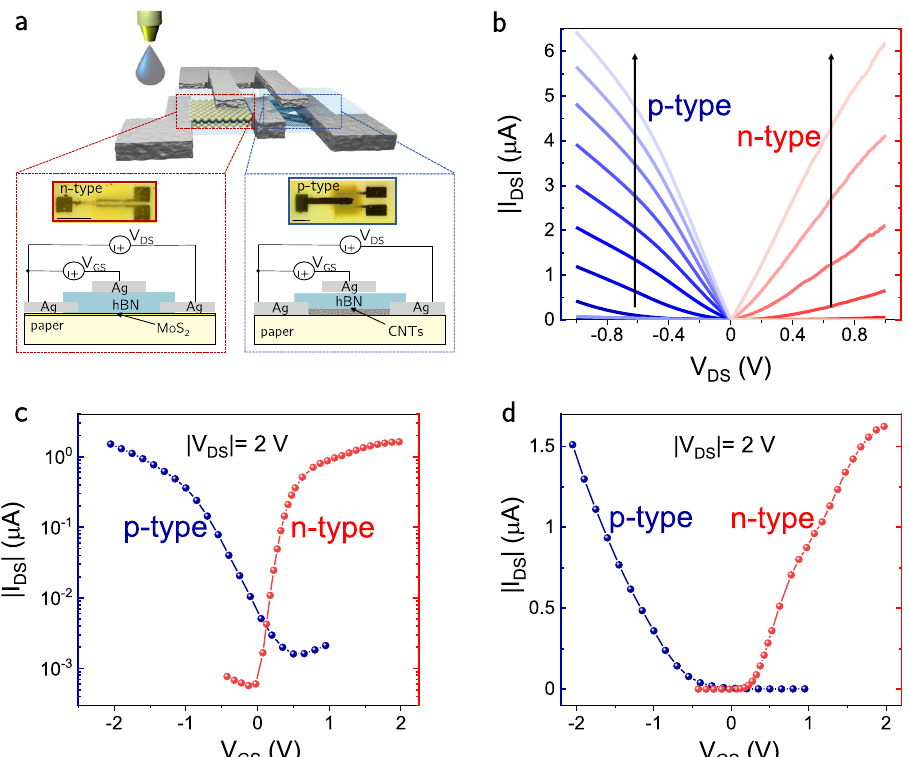
Fig. 1 Optical images and electrical characterization of the CNTs FET and MoS 2 FET in ambient conditions. a Sketch showing a CMOS inverter made of an inkjet-printed CNTs p -type FET and an inkjet-printed MoS 2 n -type FET. Inset, optical micrograph of both types of FET fabricated on paper, the scale bars correspond to 500 µm. b Output characteristics of p -type FET, obtained decreasing V GSp from + 3 to − 3 V with a step of 0.5 V (blue curves), and output characteristics of n -type FET, obtained increasing V GSn from − 3 to + 3 V with a step of 0.5 (red curves). c Transfer characteristics of a CNTs FET (blue curve) and a MoS 2 FET (red curve) measured as a function of the gate voltage for a drain voltage of − 2.0 and 2.0 V, respectively, in semi-logarithmic scale. d Transfer characteristic curves of a CNTs FET (blue curve) and a MoS 2 FET (red curve) measured as a function of the gate voltage for a drain voltage of − 2.0 and 2.0 V, respectively in linear